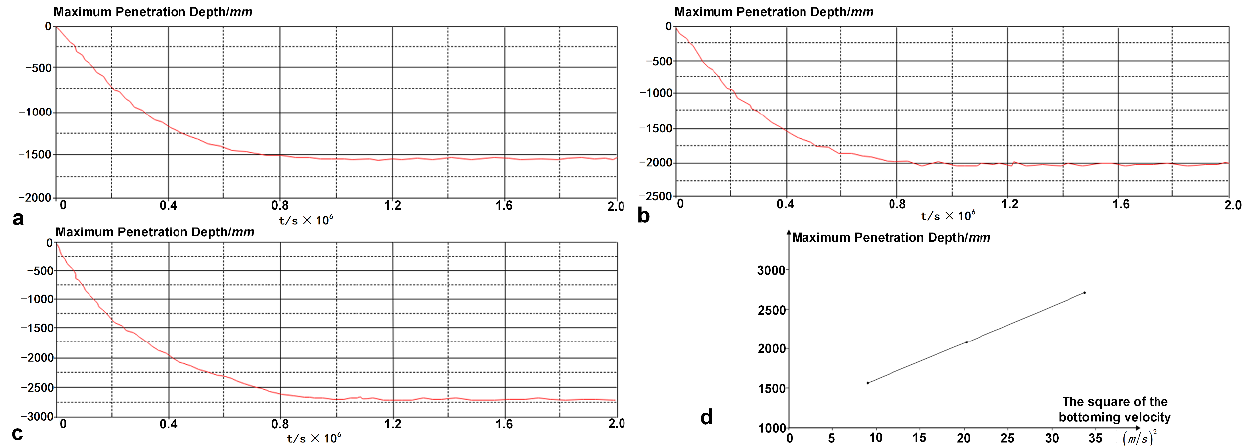
Figure 8. The maximum penetration depths of different bottoming velocities. ( a ) Case F2-1; ( b ) Case F2-2; ( c ) Case F2-3; ( d ) The relationship between the maximum penetration depth and the bottoming velocity.